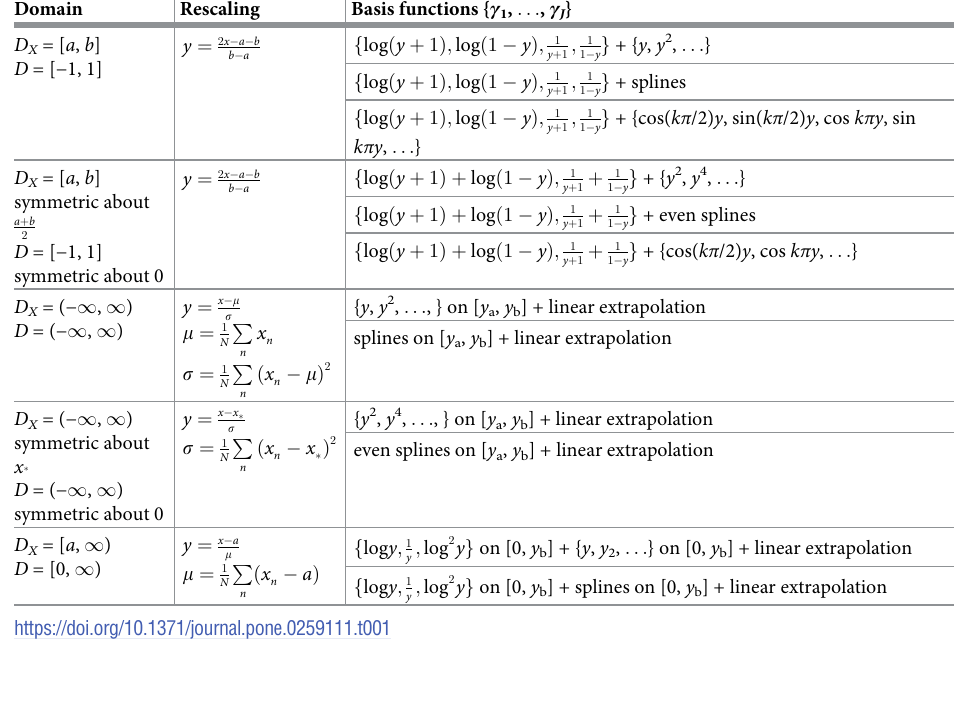
Table 1. Overview of domains and basis functions for semiparametric density estimation. Domain